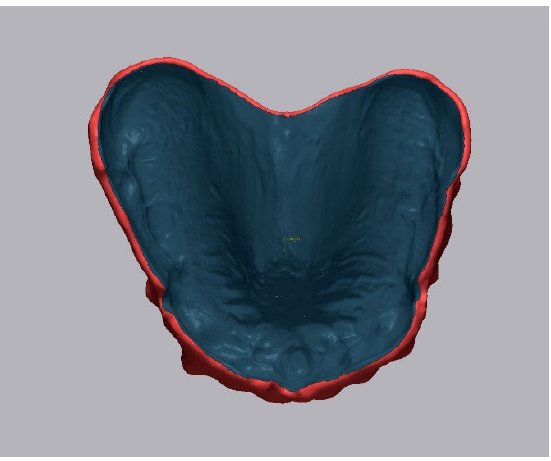
Figure 3. Segmentation of the reference dataset in Geomagic Control X (3D Systems) software for the further matching process. Only the intaglio surface (dark gray) was used for the best fit proto- col.